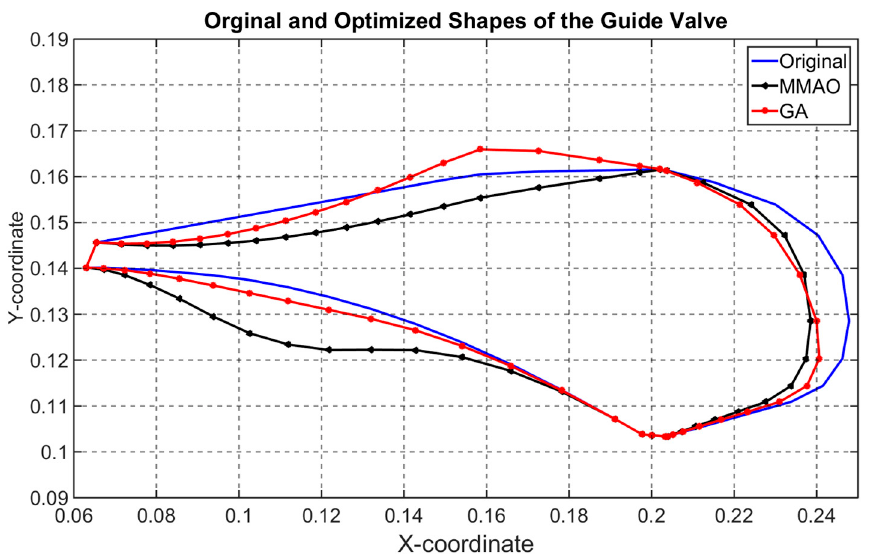
Figure 14. Original and optimized shapes of the guide valve generated from the construction points. Table 4. Parameter values from the optimization results and steady analyses’ results.